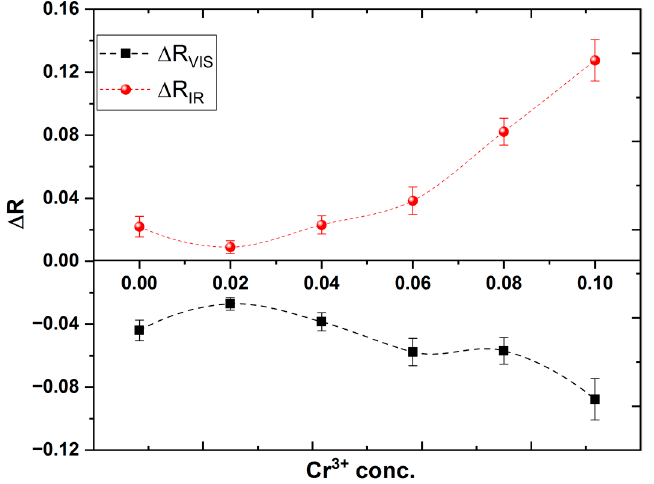
3+ concentration for all investigated thin